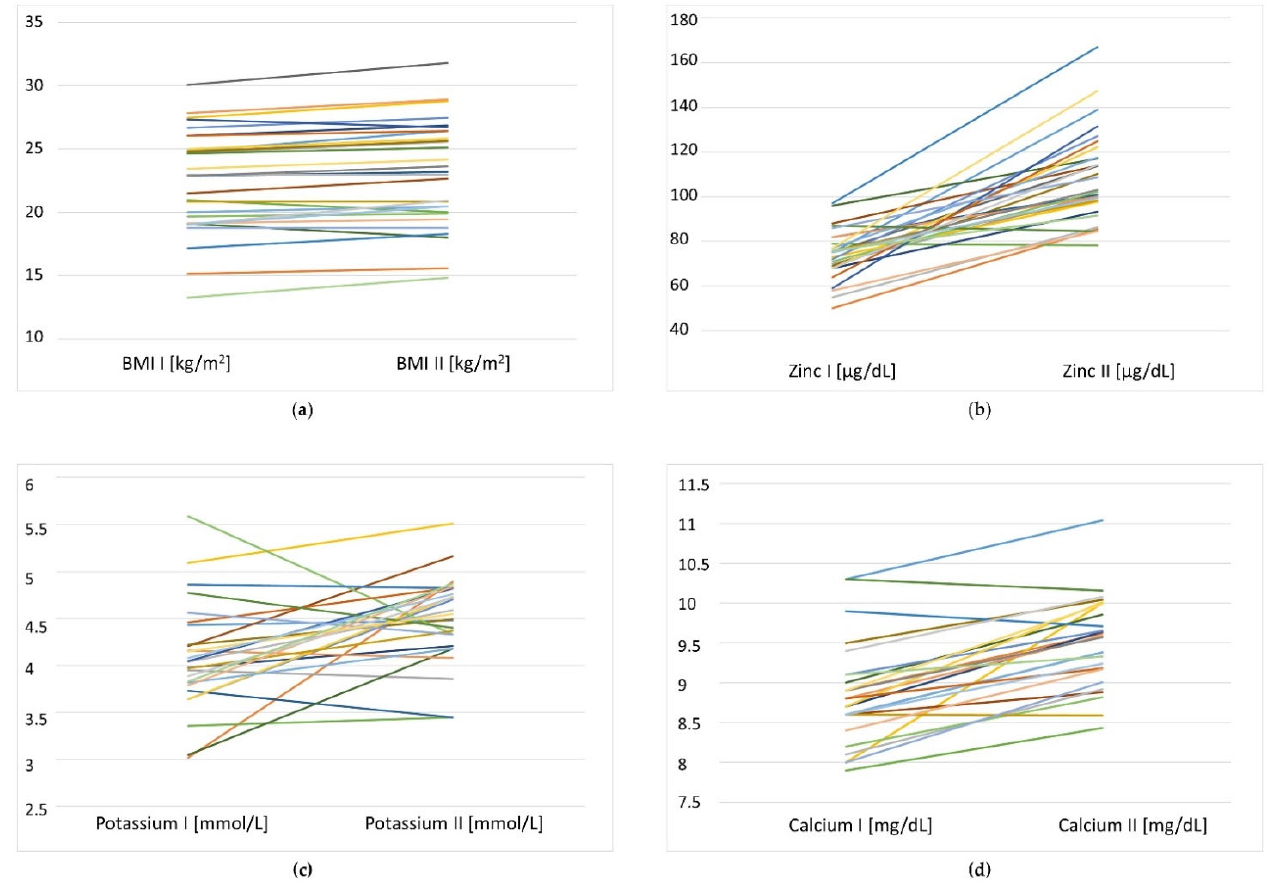
Figure 2. Individual changes in ( a ) BMI ( n = 29), ( b ) serum zinc ( n = 29), ( c ) serum potassium ( n = 28) and ( d ) serum calcium ( n = 26) in the study participants at baseline (I) and after dietary intervention (II).